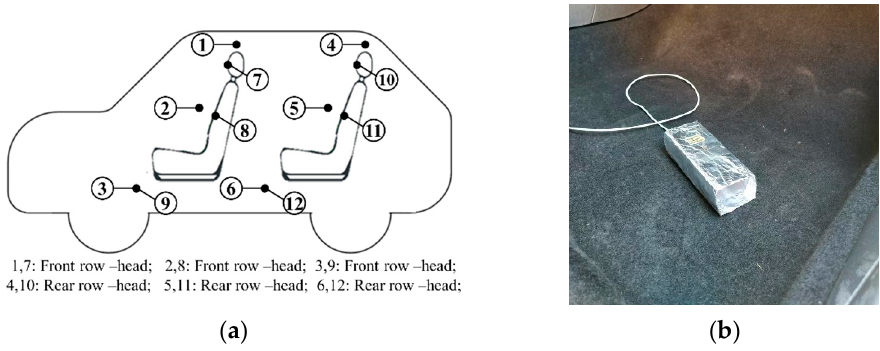
Figure 3. Measuring points in the cabin: ( a ) air and surface temperature measuring points; ( b ) raw picture of the air temperature measuring point.